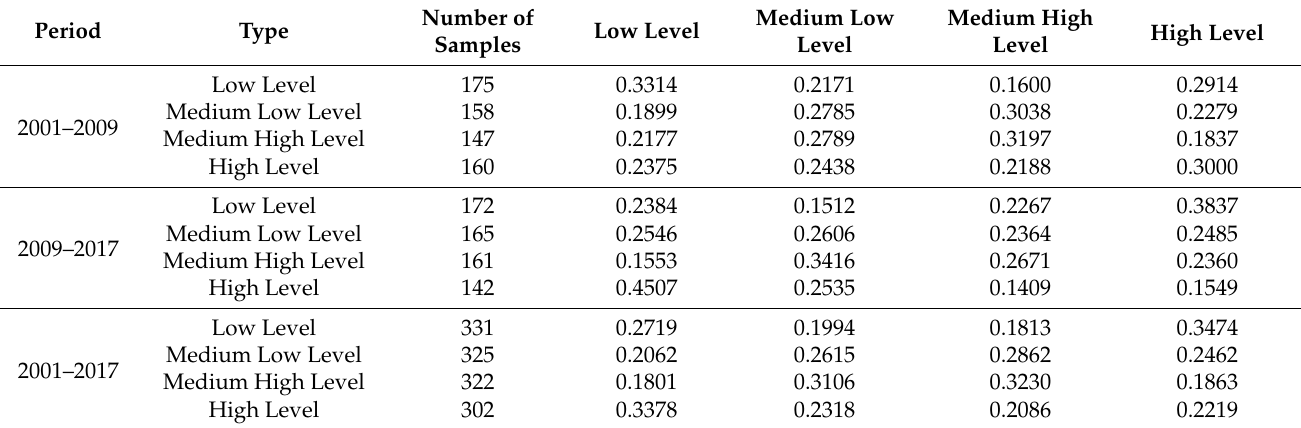
Table 3. Markov transition matrix results of GTFP of grain in Poyang Lake Basin.